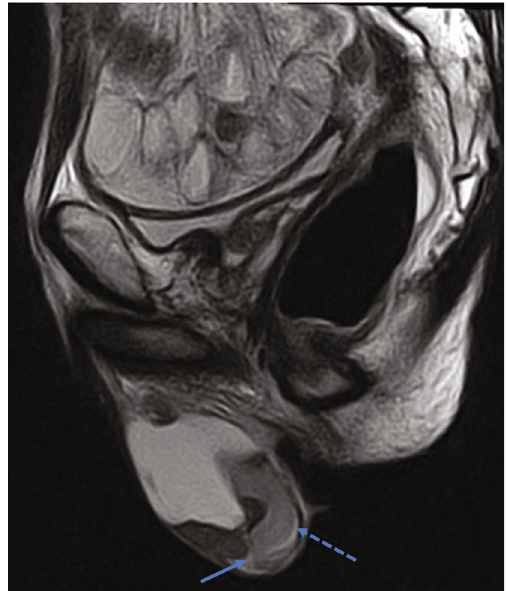
Figure 2: MRI T2-weighted image of the pelvis showing a 7 : 3 × 5 : 4 × 4 : 5 cm testicular mass consisting of a cystic solid tumor (arrow) as well as normal testicle components (dashed line